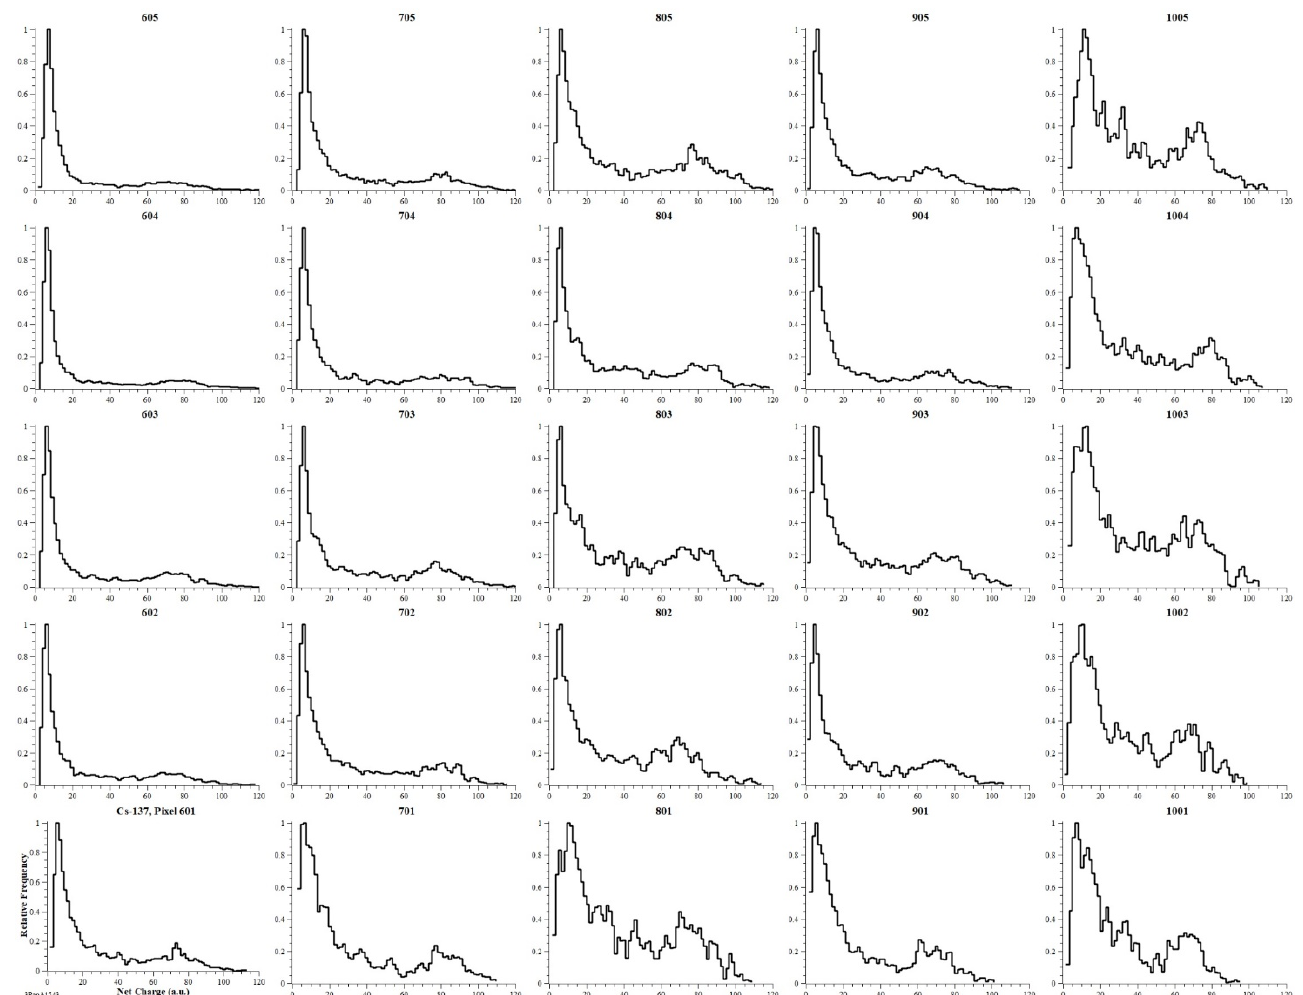
Figure A3. Cs-137 pulse-height spectra per crystal-pixel for the third quarter of the array which includes the pixels with RR > 5 and CC ≤ 5. The common axes and plot descriptions have been shown only once in the bottom-left frame for better clarity. Spectra have undergone denoising smoothing, and have been built by using 1.5 ch.u. binning. Frequency values have been normalized, pixel by pixel, to the respective maximum value.